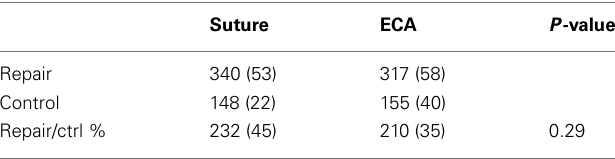
Table 1 | Mean (SD) morphometric data on cross-sectional distribution area ( μ m 2 × 10 3 ) and correlation (%) between repair and control, respectively, of RLMs representing the LGC in the lateral ventral horn throughout the L5 spinal cord segment 6months after transection and repair of the left rat sciatic nerve with either ECA or epineurial sutures ( n = 8 in each group).